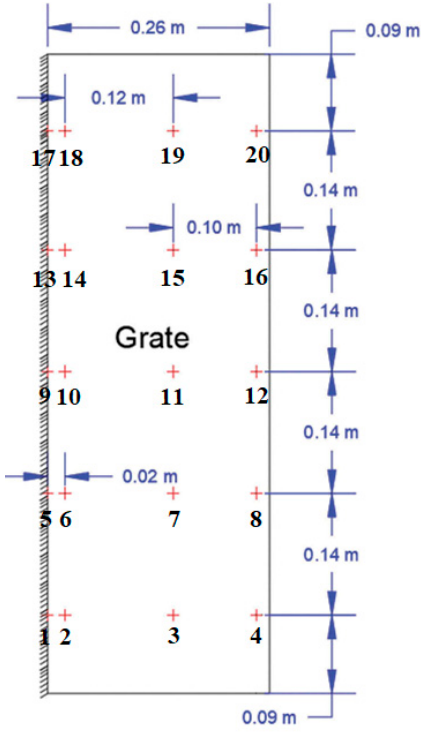
Figure 3. Location of 20 points over the grate [42].